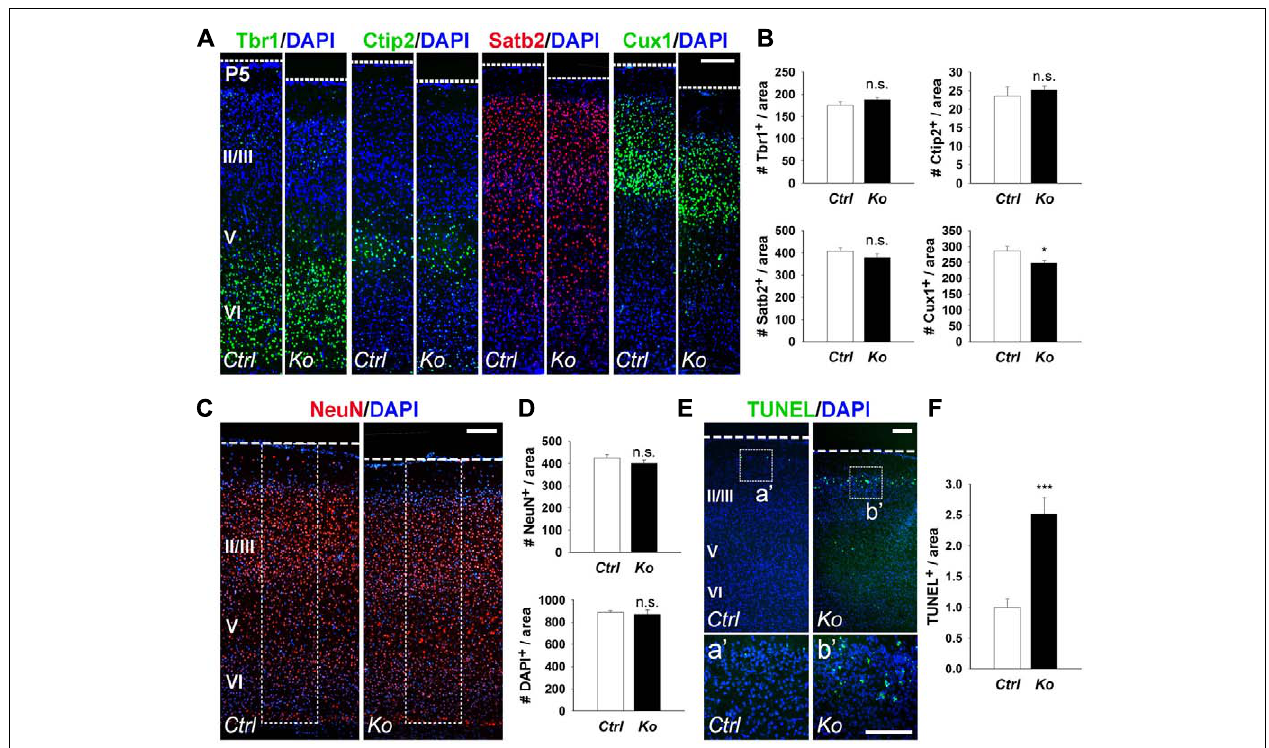
FIGURE 2 | Conditional Dicer loss in mature neurons does not significantly alter cortical lamination and neuronal production, and exhibits a transitory increase in cell death at P5. (A,B) The numbers of early-born neurons labeled withTbr1 and Ctip2 were unaffected in P5 Nex-Cre-Dicer Ko ( Ko ) cortices, compared to controls ( Ctrl ).The numbers of late-born neurons labeled with Satb2 were unaffected and Cux1 were decreased in P5 Dicer Ko cortices, compared to controls. (C,D) Numbers of NeuN + and DAPI + cells were unaffected in the cortical wall of P5 Dicer Ko